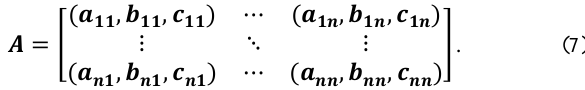
Figure 2. A triangular fuzzy number representation